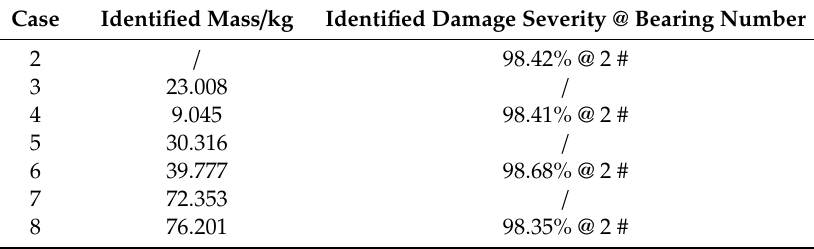
Table 9. The identification results of additional mass and bearings